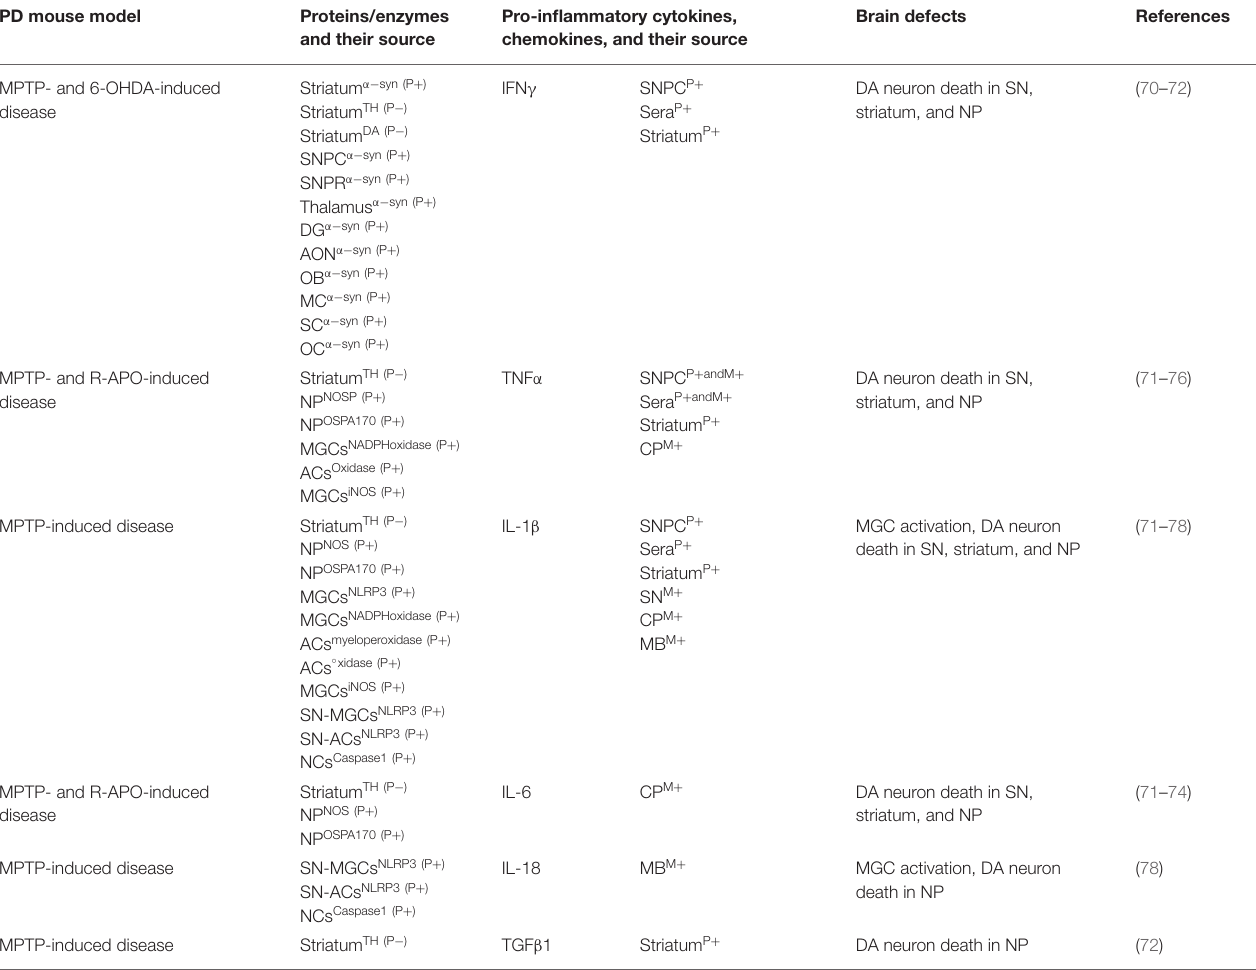
TABLE 1A | Cytokines and their source in the mouse model of idiopathic PD. PD mouse